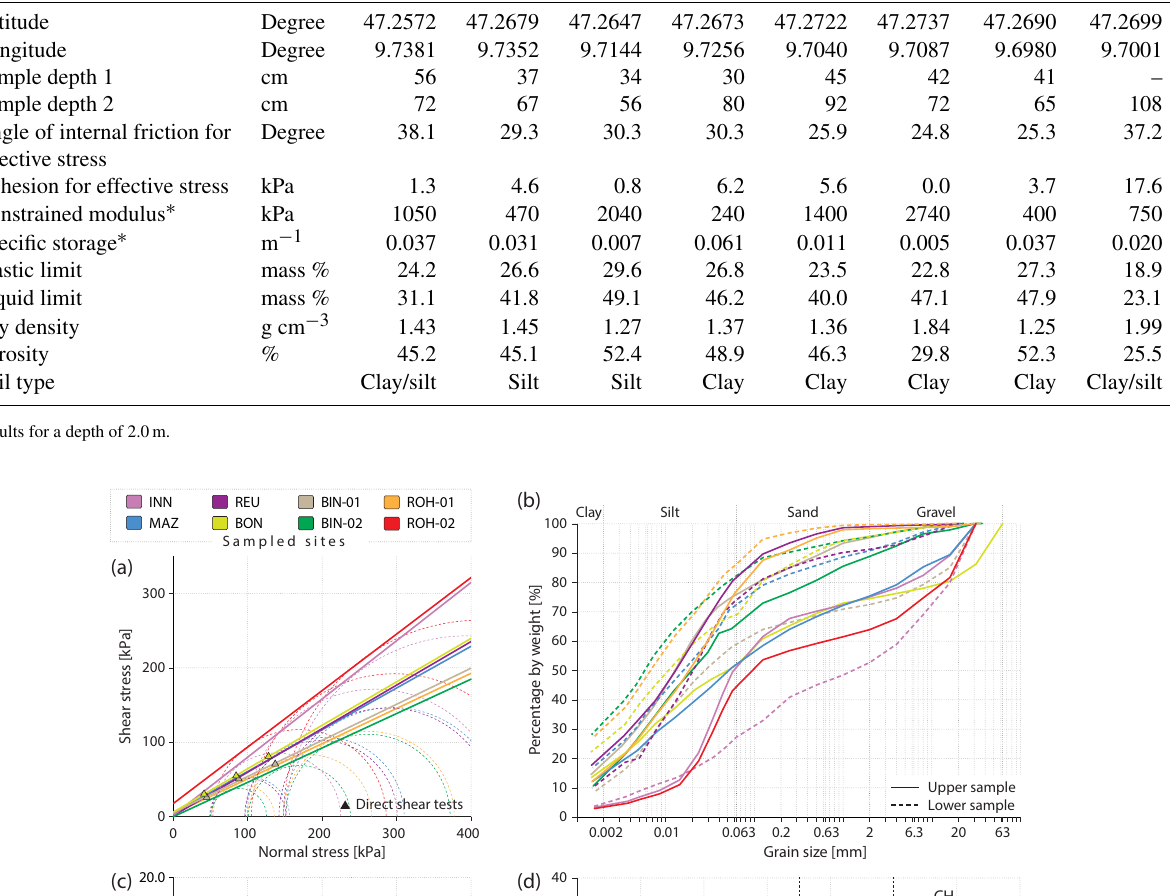
Table 3. Metadata for the eight sampled landslide sites and results of the conducted laboratory tests. Parameters